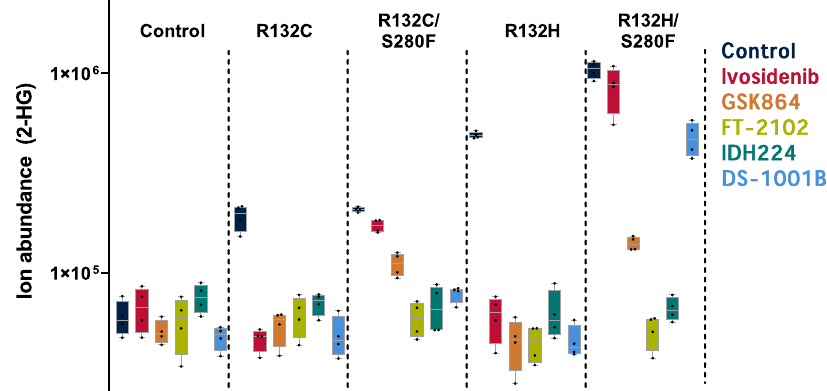
Fig. 5 | In fl uence of inhibitors on 2-HG levels in cells bearing recombinant R132C, R132C/S280F, R132H and R132H/S280F. LN18 cells were treated with the inhibitors ivosidenib, GSK864, FT-2102, IDH224, and DS-1001B in DMSO ( fi nal concentration: 5 µ M). 2-HG levels were determined by anion-exchange chromato- graphy coupled to MS 51 (errors: standard errors of the mean, n =4 independent replicates).Note that, whilst ivosidenibis not/poorlyactiveinreducing 2-HGlevels